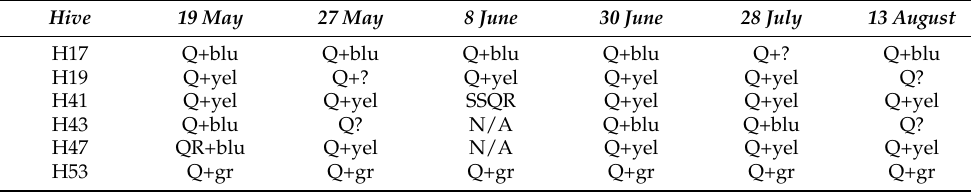
Table 12. Queen status inspections of monitored hives; all dates in columns were in 2021; blu—queen from breeder 1 colored blue; gr—queen from breeder 2 colored green; yel—queen from breeder 2 colored yellow; Q+—queen spotted; Q+?—queen not spotted but its presence is clear from eggs in cells; Q?—queen not spotted; SSQR—supersedure queen removed; QR—queen spotted and removed; N/A – not